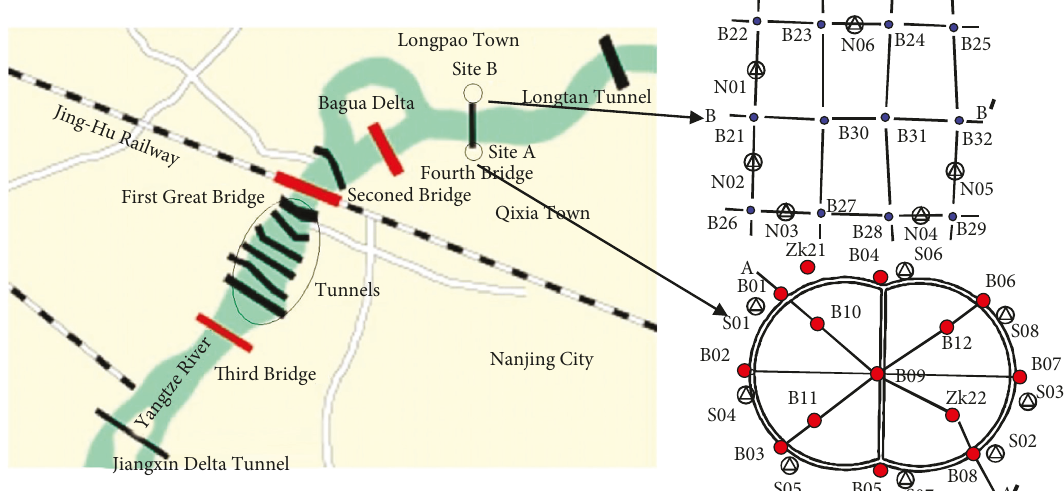
Figure 1: Layout of existing bridges and new alignments crossing the Yangtze River and location of the study